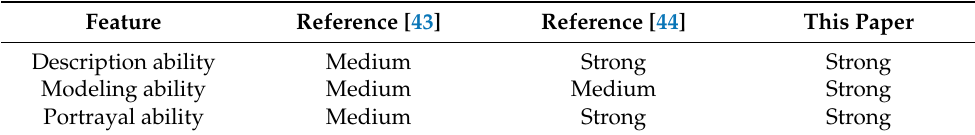
Table 9. Comparison of features of different performance evaluation